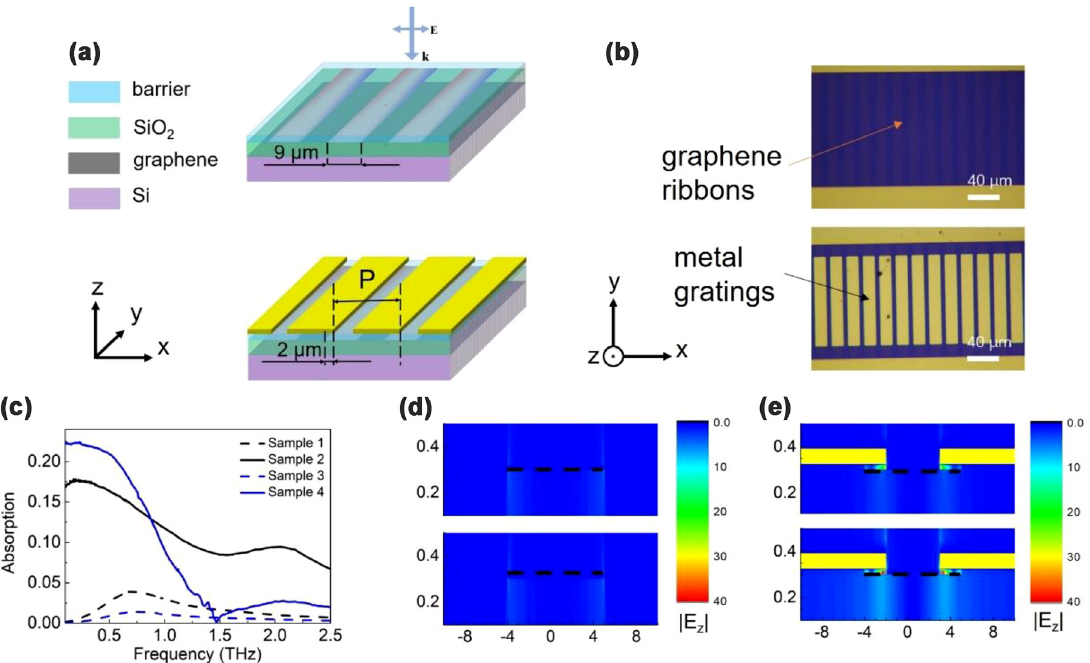
| distribution. (a) The simulated graphene micro-ribbon structure without Figure 1: The designed structure, their absorption spectra and | E z (upper panel) and with (lower panel) metallic gratings. (b) The microscopic images of Sample 1 (upper panel) and Sample 2 (lower panel). (c) The absorption spectra for Sample 1 (black dashed curve), Sample 2 (black solid curve), Sample 3 (blue dashed curve) and Sample 4 (blue | distribution of Sample 1 (upper panel) and Sample 3 (lower panel) at 0.6 THz, with graphene indicated by black solid curve). (d) The | E z | distribution of Sample 2 (upper panel) and Sample 4 (lower panel) at 0.6 THz, with graphene indicated by black dashed lines. (e) The | E z dashed lines and metal indicated by golden